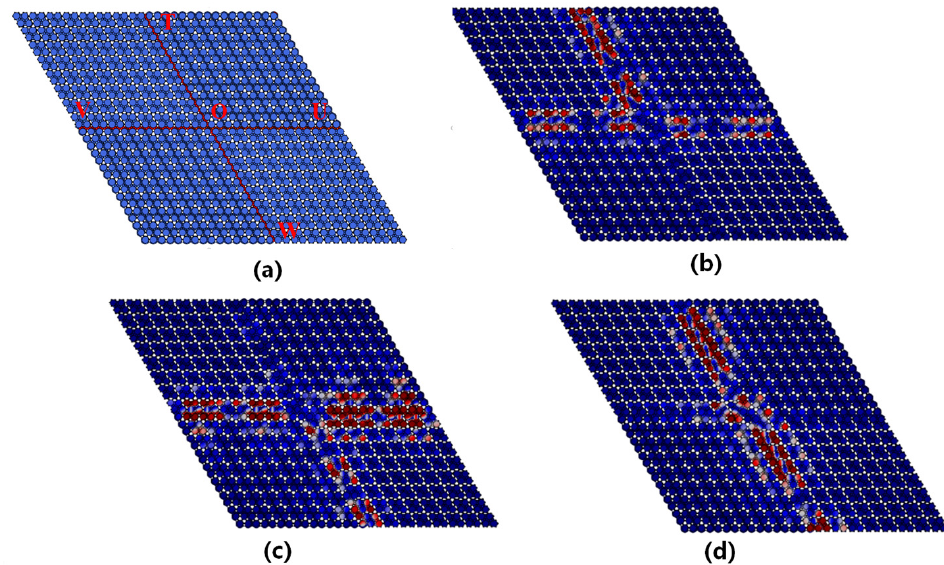
Figure 8. Direction-selective elastic energy splitter: ( a ) Schematic diagram of the elastic energy splitter; ( b ) Transport effect when the exciting point is set in T; ( c ) Transport effect when the exciting point is set in W; ( d ) Transport effect when the exciting point is set in O.